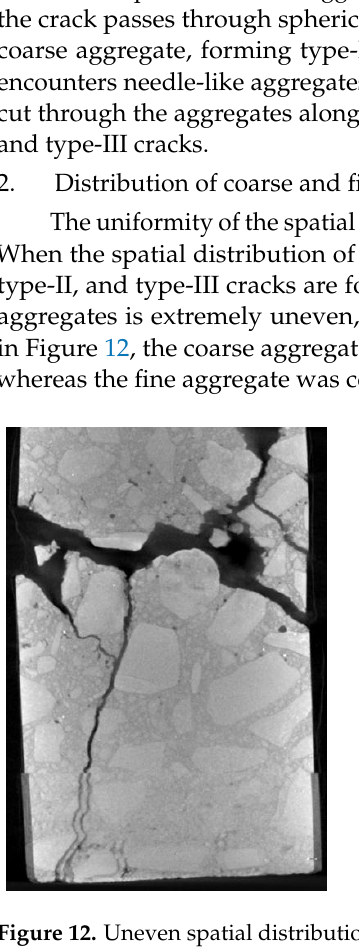
Figure 11. Spherical aggregates ( left ) and needle-like aggregates ( right ).